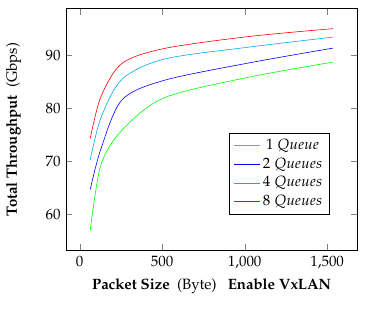
Figure 7. Throughput with Various Queues..